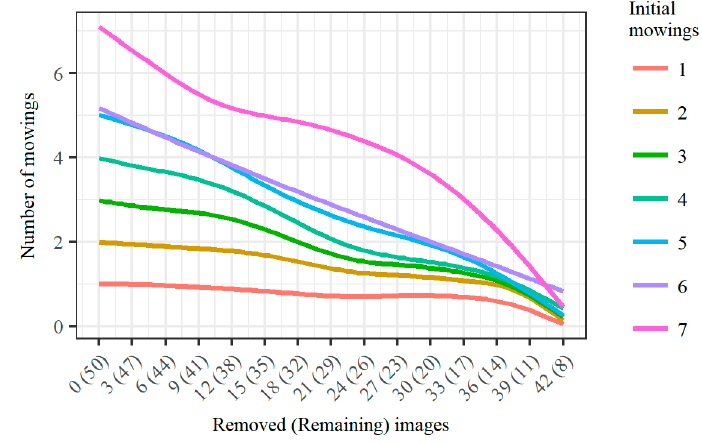
Figure 11. Average numbers of mowings detected with reduction of input image dataset, grouped by number of initial mowings.